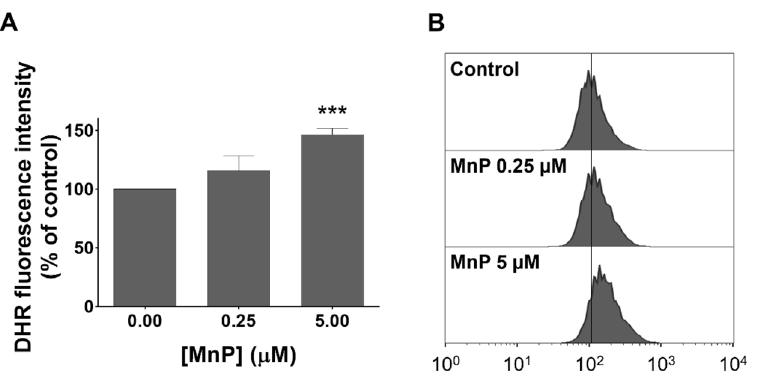
Figure 4. Exposure to MnP led to an increase in intracellular ROS in 786-O cells. The intracellular ROS levels after 12 h of exposure were detected by flow cytometry using the DHR probe. ( A ) Values represent mean of the median fluorescence intensity ± SD (n = 4), *** p < 0.001 (Student’s t-test). ( B ) Representative histograms from one assay are shown.